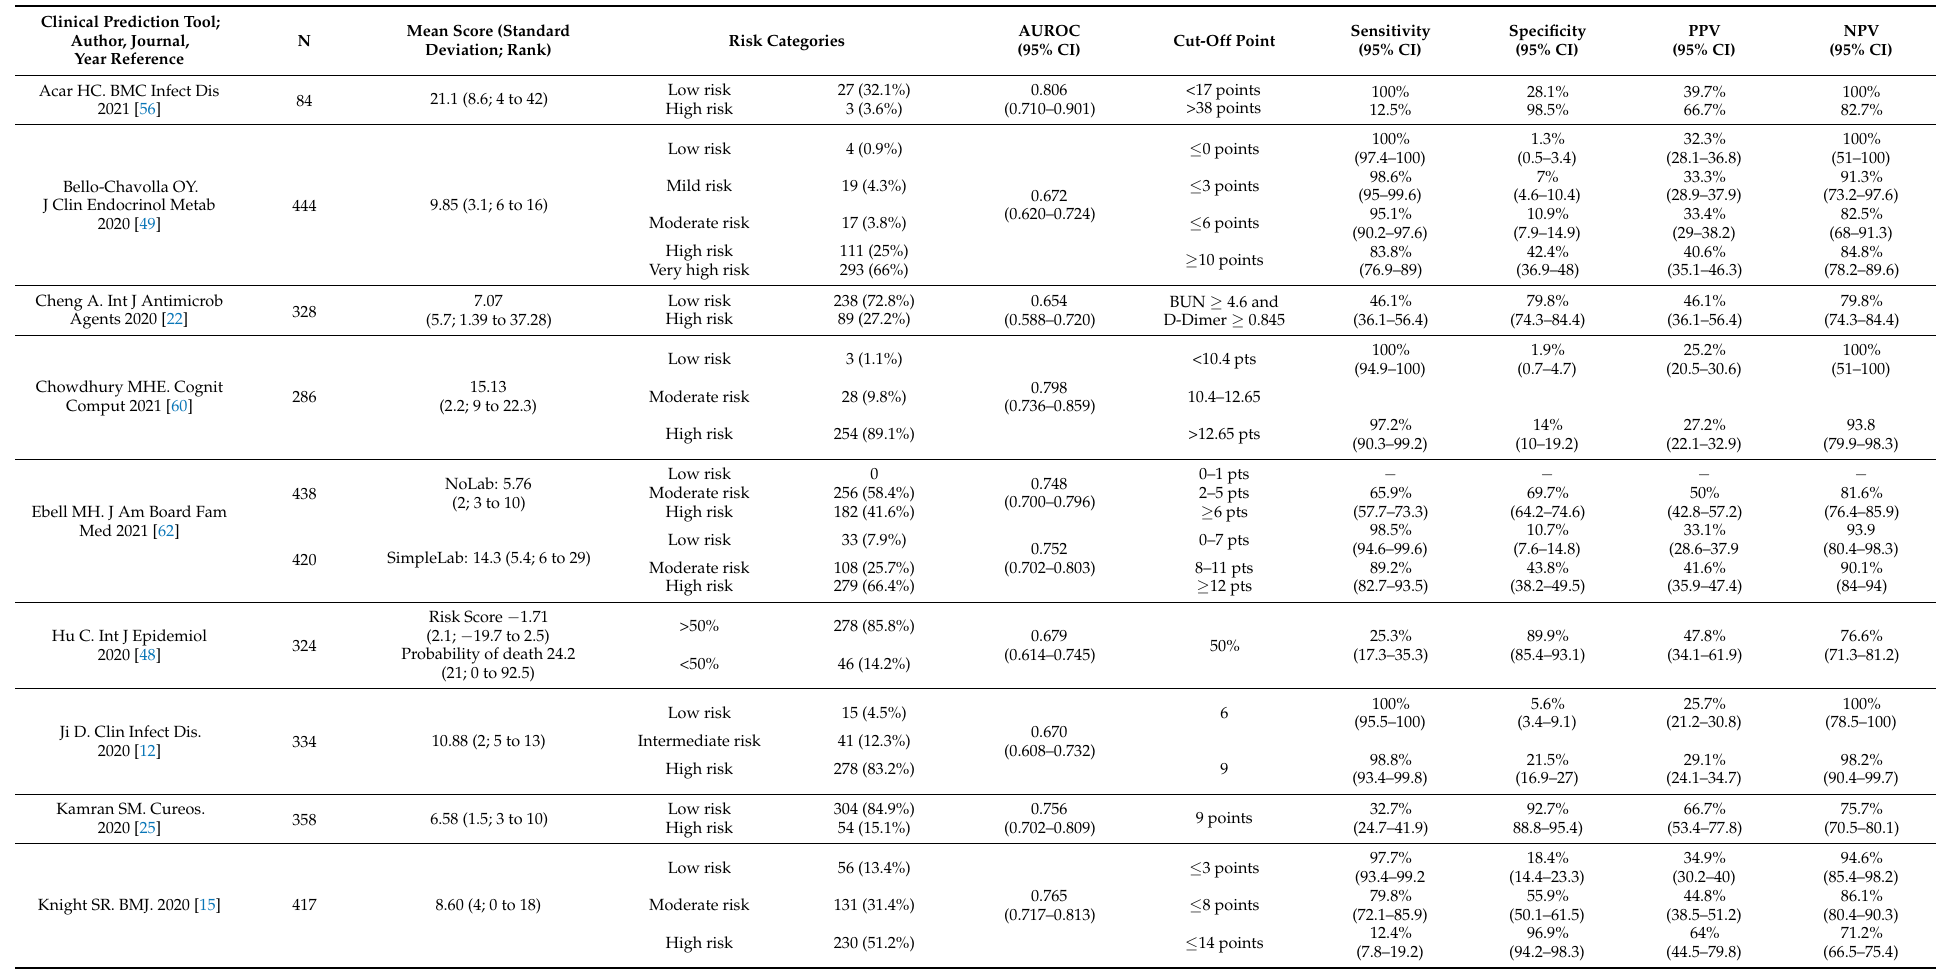
Table 1. Prognostic models for mortality from COVID-19, externally validated in a cohort of patients admitted to Tomelloso General Hospital, Spain. Risk categories and cut-off points were defined according to original models. Performance of each model (area under receiver operator curve (AUROC), sensitivity (%), specificity (%), and positive predictive value (PPV)/negative predictive value (NPV) (%) with 95% confidence intervals), if reported, were calculated over model validation subcohort of N